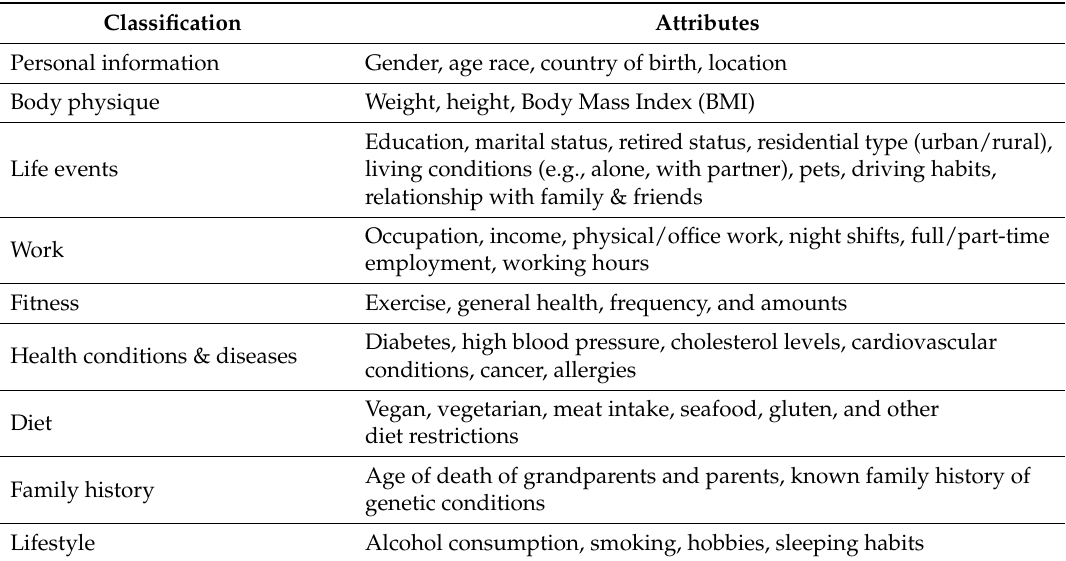
Table 3. General questionnaires, which can be completed by users. These data can be provided without consulting a user’s health service